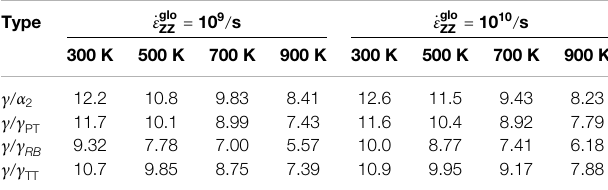
TABLE 1 | Yield stress of Type-1 models for different temperatures and interface types at strain rates of _ ε glo ZZ (cid:2) 10 9 / s and _ ε glo ZZ (cid:2) 10 10 / s